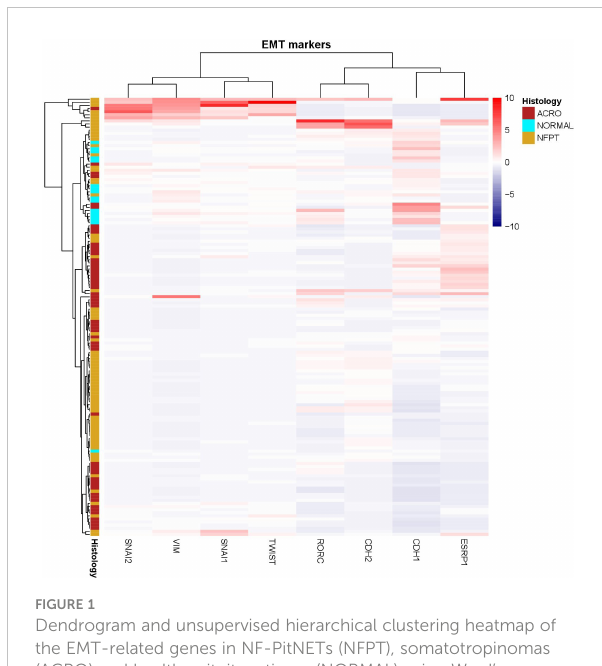
FIGURE 1 Dendrogram and unsupervised hierarchical clustering heatmap of the EMT-related genes in NF-PitNETs (NFPT), somatotropinomas (ACRO) and healthy pituitary tissue (NORMAL) using Ward ’ s minimum variance method and Minkowski distance.